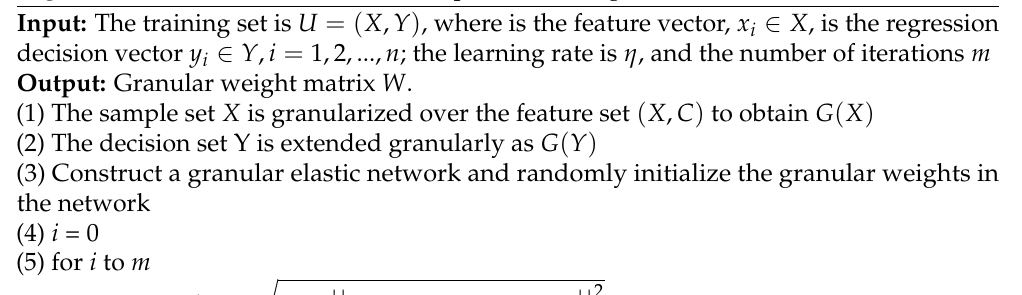
Algorithm 1 Granular elastic network optimization